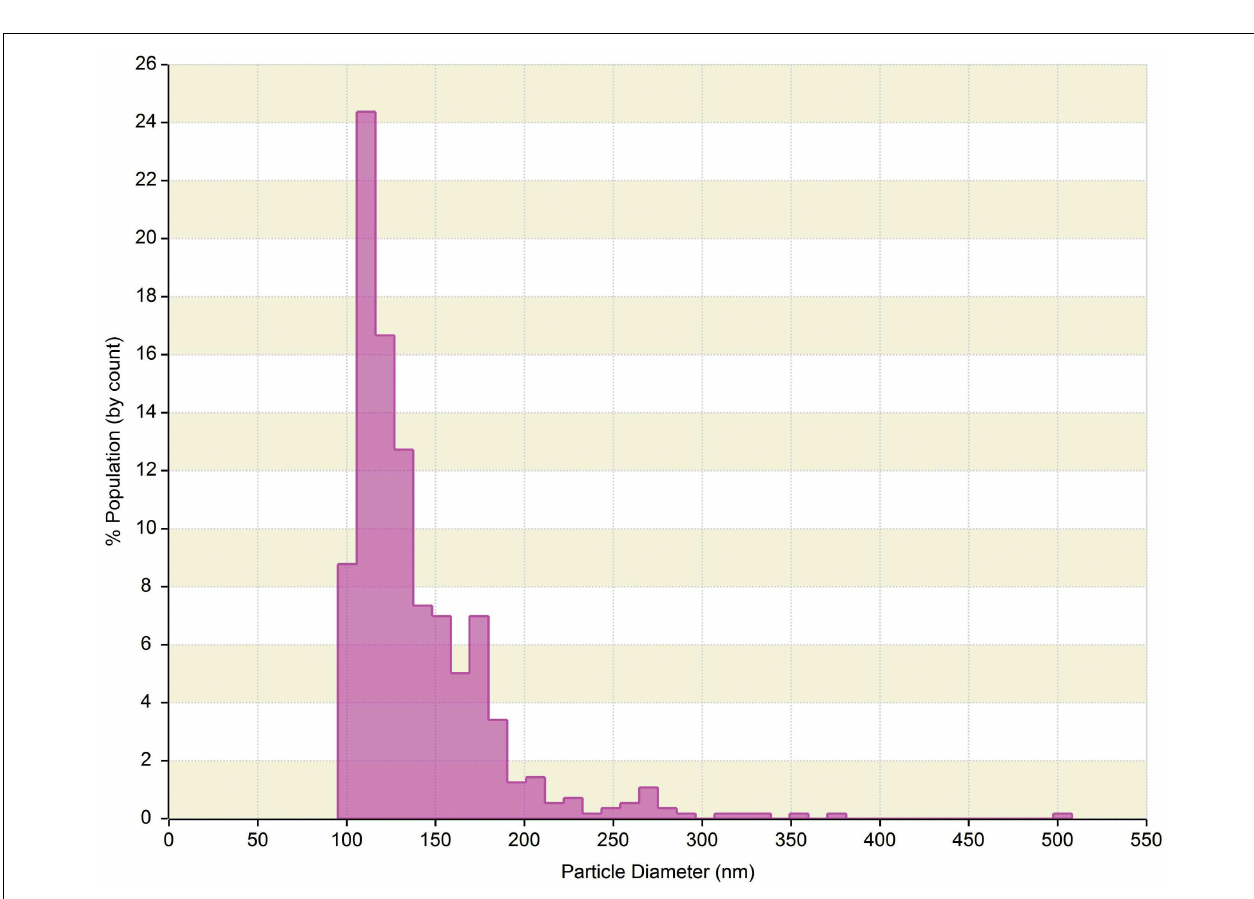
FIGURE 3 | qNano generated data of human serum derived extracellular vesicles (ECVs). Plot depicts particle size diameter vs. percentage (%) of population.The concentration was reported as 1.4 × 10 10 particlesml − 1 with mode of 120nm.